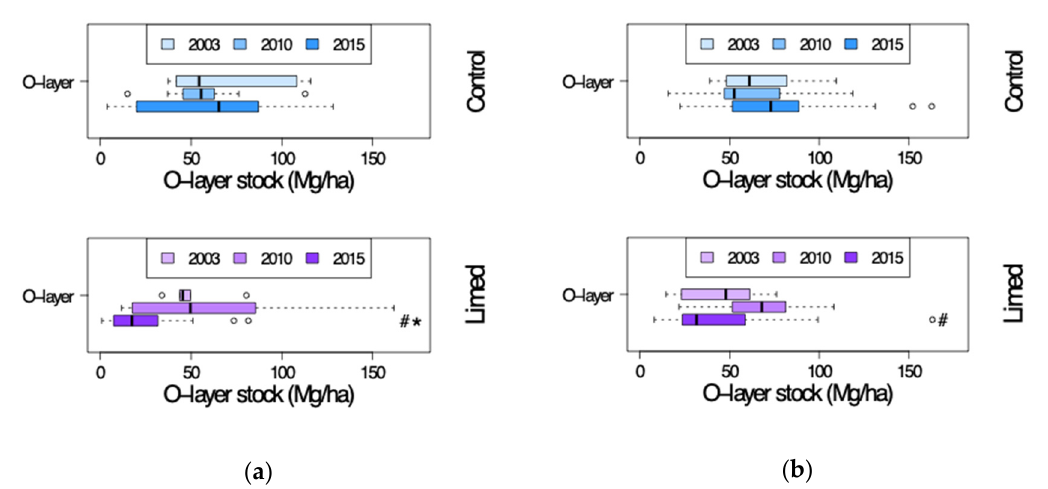
Figure 9. Organic layer stocks of control and lime treated plots in 2003–2015. ( a ) G1 study sites and ( b ) G2 study sites. #—limed plots significantly different from control; *—significant differences between current and previous sampling campaign.